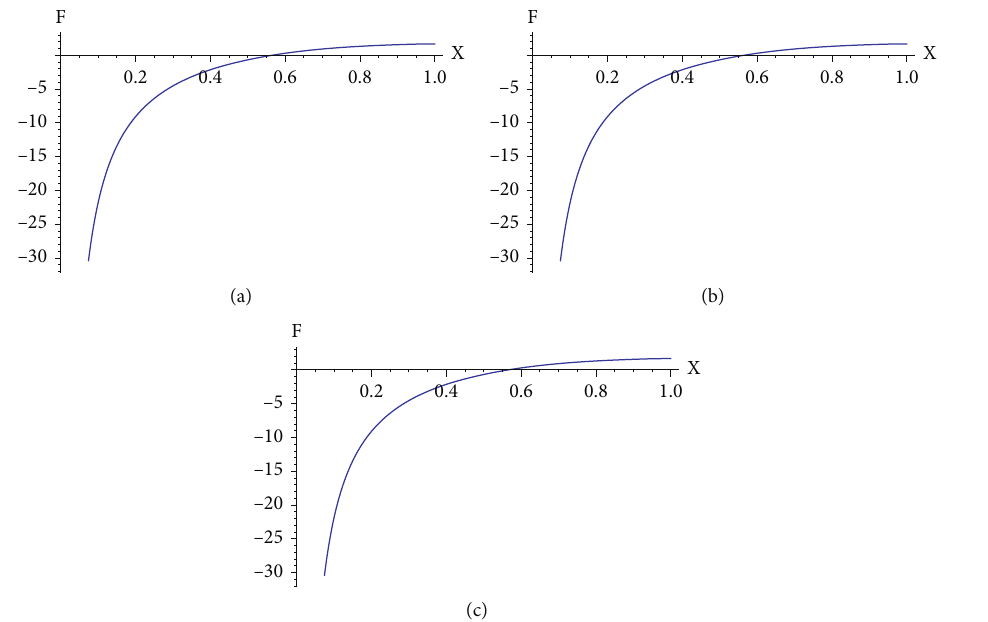
= 0 : 03 , (b) for ϕ 2 = 0 : 04 , and (c) for ϕ 2 + +